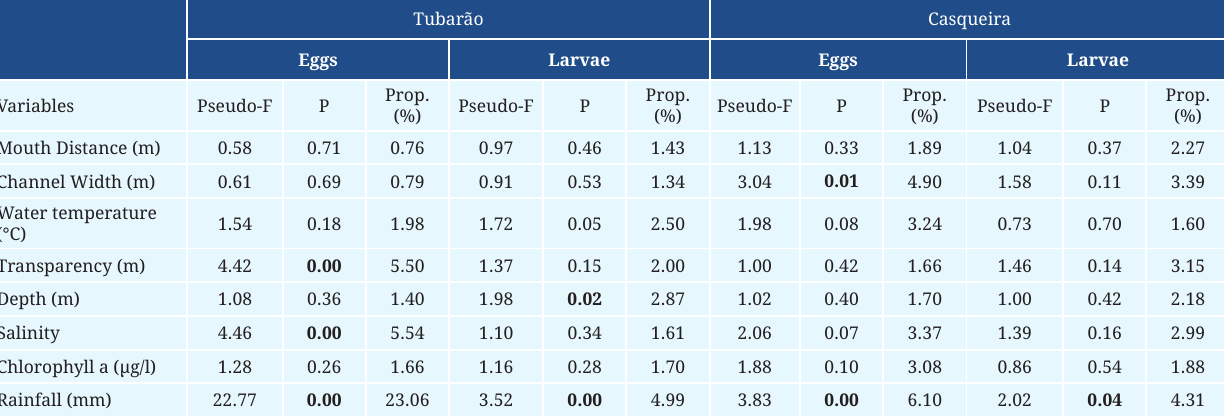
TABLE 4 | DistLM marginal test showing the influence of environmental variables on the estuarine ichthyoplankton (Tubarão and Casqueira river estuaries, Semiarid Northeastern Brazilian coast). P-values in bold are significant. Prop. = Proportion